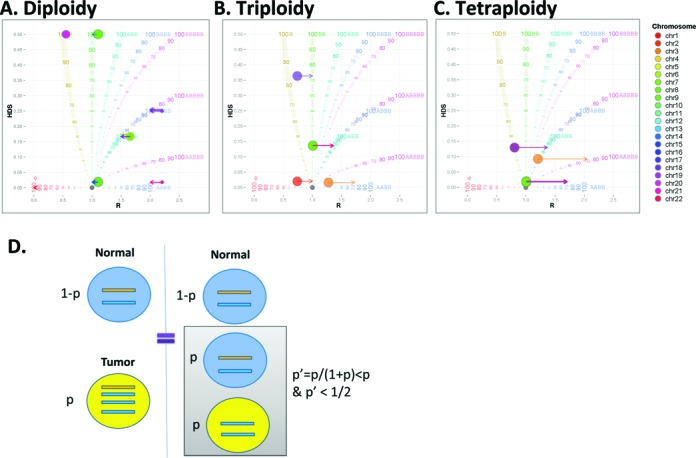
Copy ratio score adjustment and the lack of identification due to high tumor ploidy. The copy ratio score measured from the NGS data is not the actual copy ratio score, the adjustment Φ depends on the tumor purity and the tumor ploidy Φ = (τtp + 2(1 – p))/2. In the plots, (A) the diploidy, (B) triploidy and (C) tetraploidy states are illustrated by the simulated data sets: sam2 (P = 100%), sam14 (P = 72.3%) and sam15 (P = 66.7%), respectively. The bubbles represents the genomic segments positioned by the HDS scores and the raw R scores, with the color corresponding to each chromosome. The horizontal arrows indicate the shift of the bubbles following copy ratio adjustment. (D) One tetraploiy sample with purity p could yield the same HDS and R scores as a diploidy sample with the purity p’ = p/(1 + p) < p, where p’ ≤ 0.5. Specifically, it is difficult to distinguish the diploidy tumor with low purity from the tetraploidy tumor with a higher purity by the HDS and R scores alone.